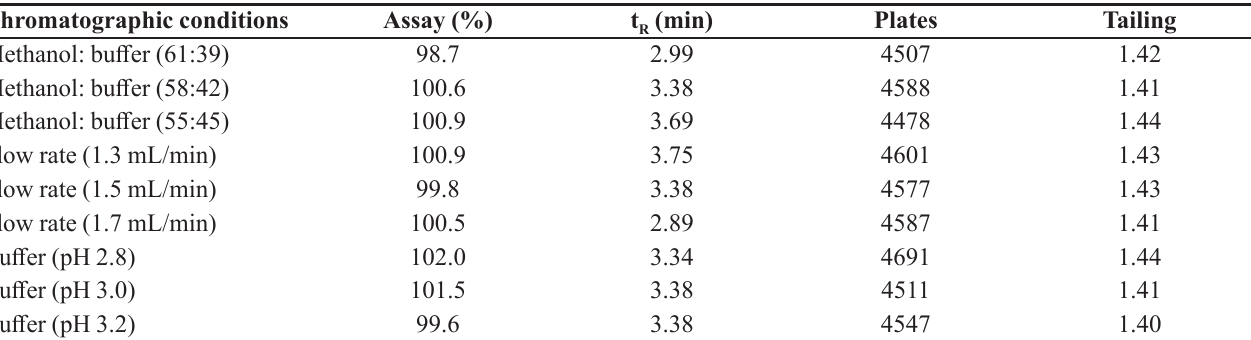
TABLE III - Robustness study of Gatifloxacin Chromatographic conditions Plates Tailing